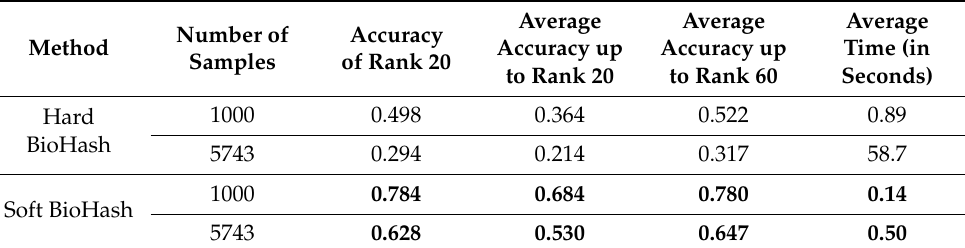
Table 1. Comparison of the retrieval accuracy results and the average execution time in seconds consumed in the retrieval process.